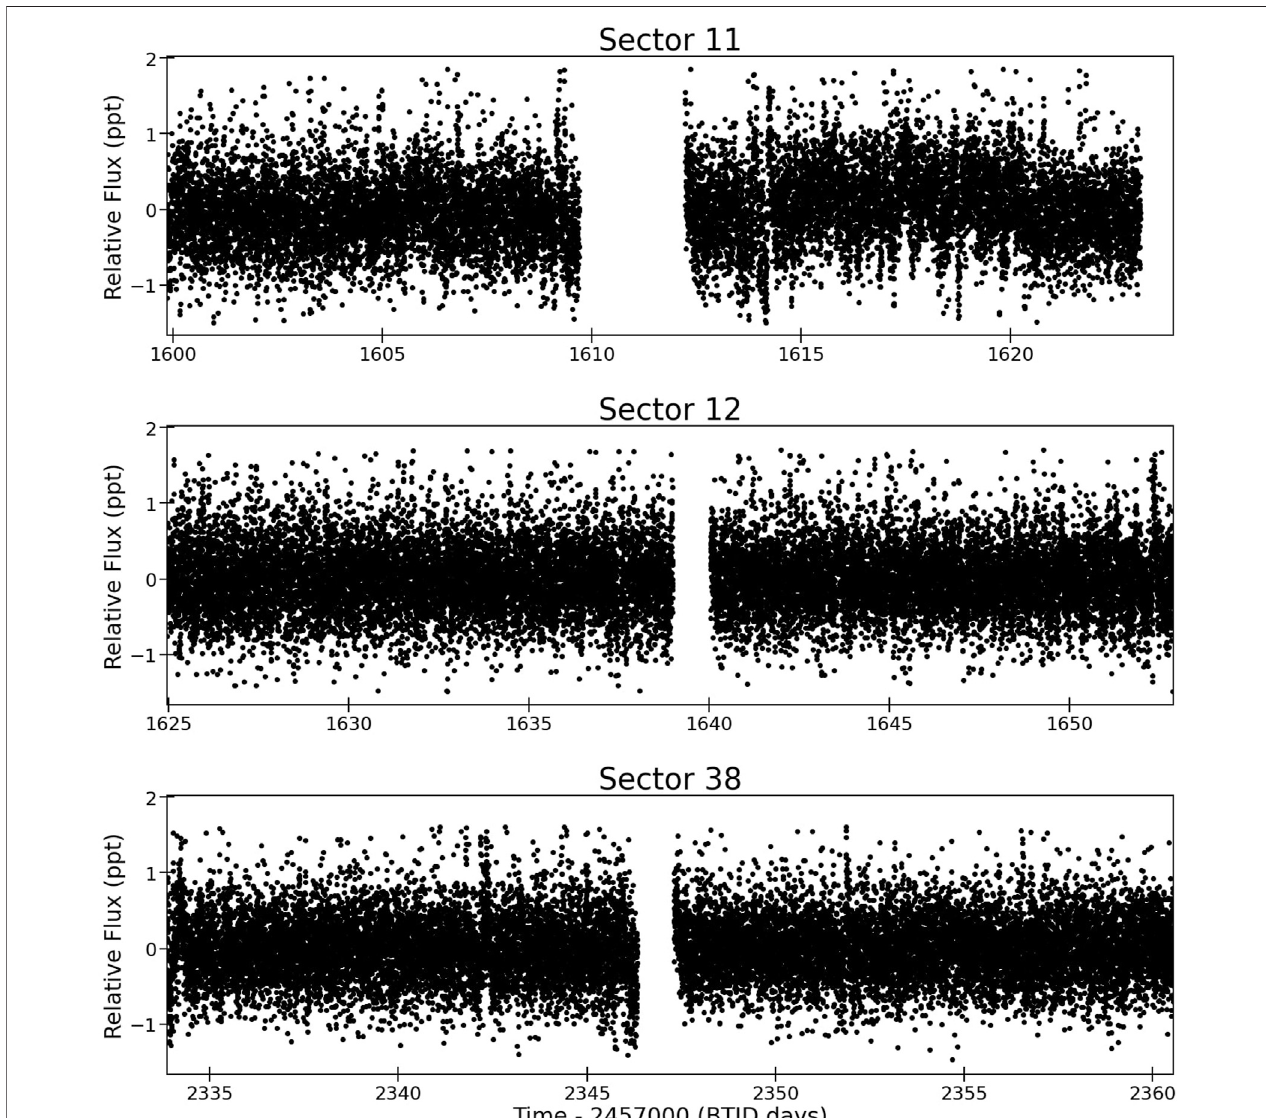
FIGURE 2 | After fl are modeling and removal, we are left with these cleaned light curves on which we conduct our planet search.